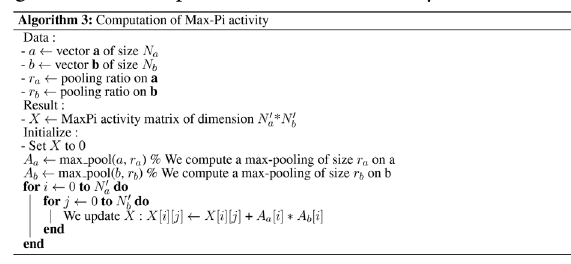
Algorithm 3. Computation of Max-Pi